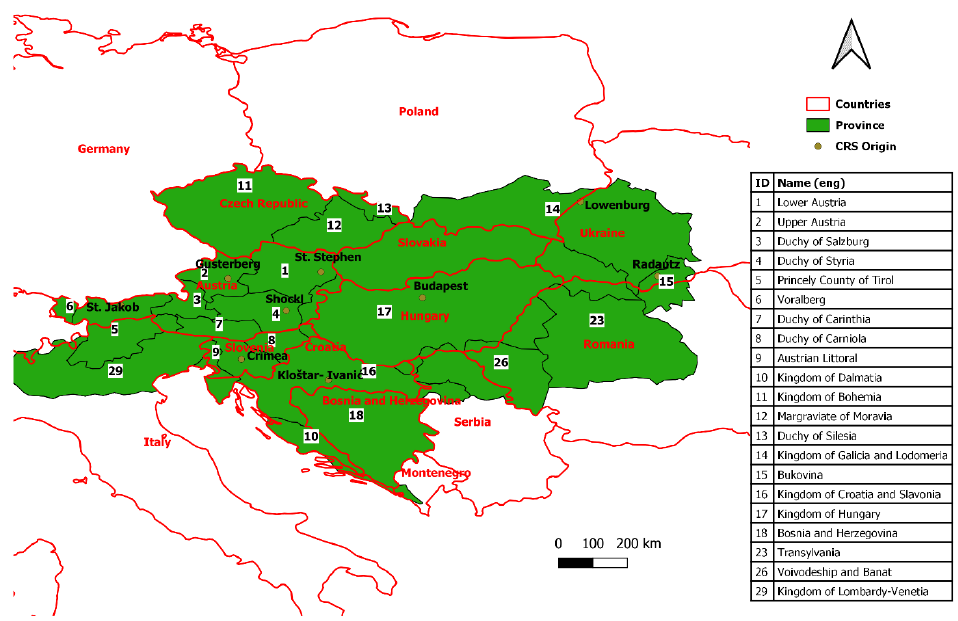
Figure 1. Provinces, countries and coordinate reference system (CRS) origin of Franciscan Cadastre. Source: own compilation.